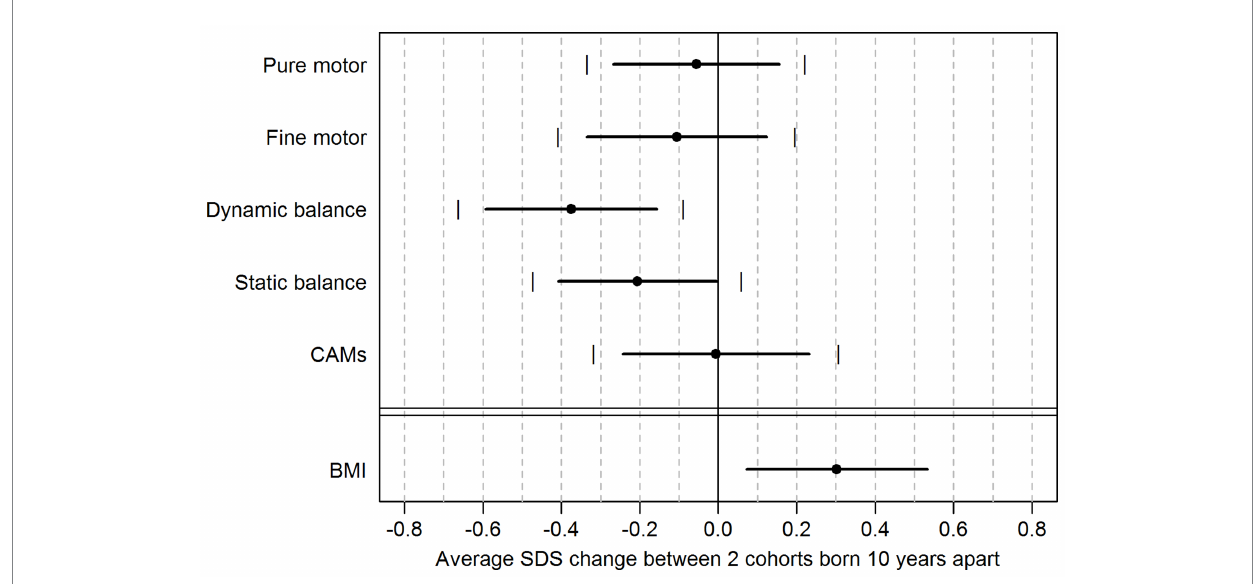
FIGURE 1 Estimated secular trend based on ZLS-3 data: average change in SDS between two cohorts born 10 years apart for five motor components of the ZNA and BMI, with 95% CI with (vertical lines) and without (horizontal lines) Bonferroni correction for multiple testing of motor components. All estimates are adjusted for age, sex, and SES. Positive values suggest that children born in year Y performed better and had higher BMI than peers of the same age and sex born in year Y-10. Negative values suggest that children born in year Y performed worse and had lower BMI than peers of the same age and sex born in year